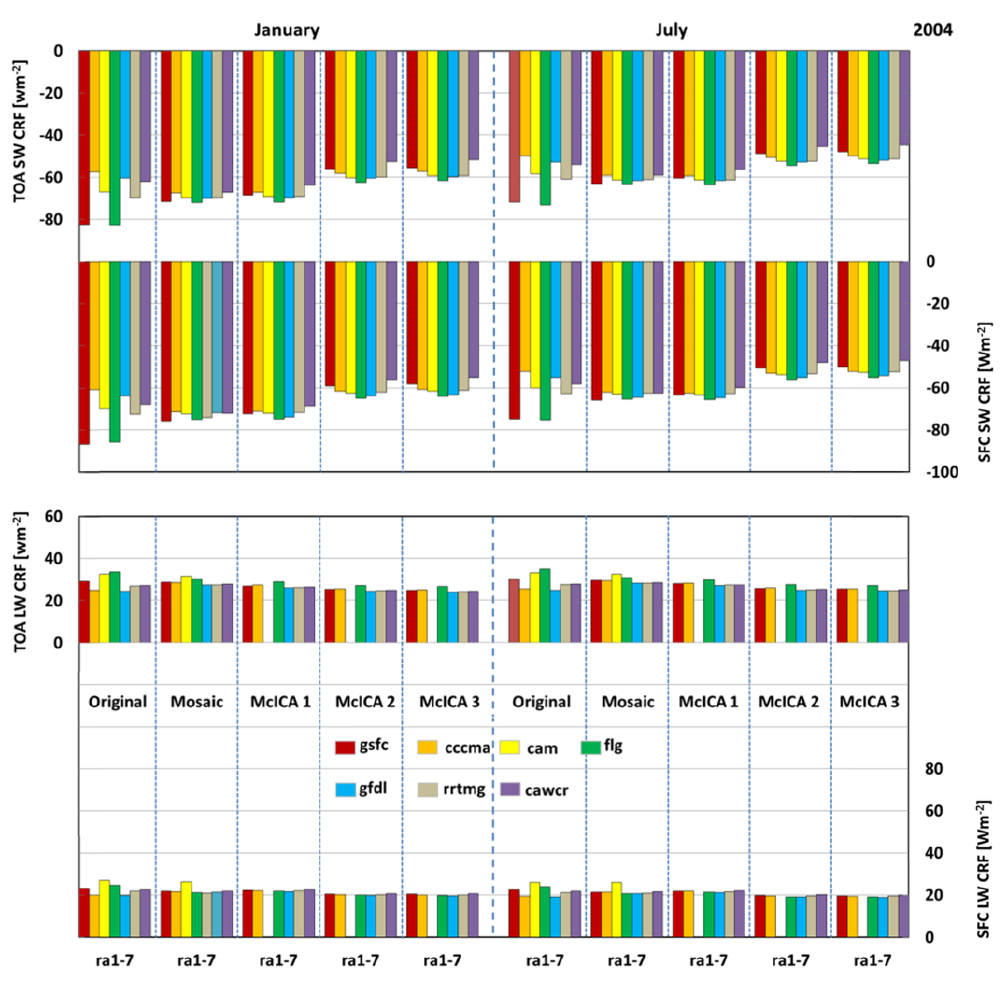
Fig. 8. The effects of cloud overlap treatment comparing the original scheme, mosaic, and McICA with three cloud generators on TOA and surface (SFC) SW and LW cloud radiative forcing (CRFs) averaged over [60 ◦ S–60 ◦ N] for January (left) and July (right)